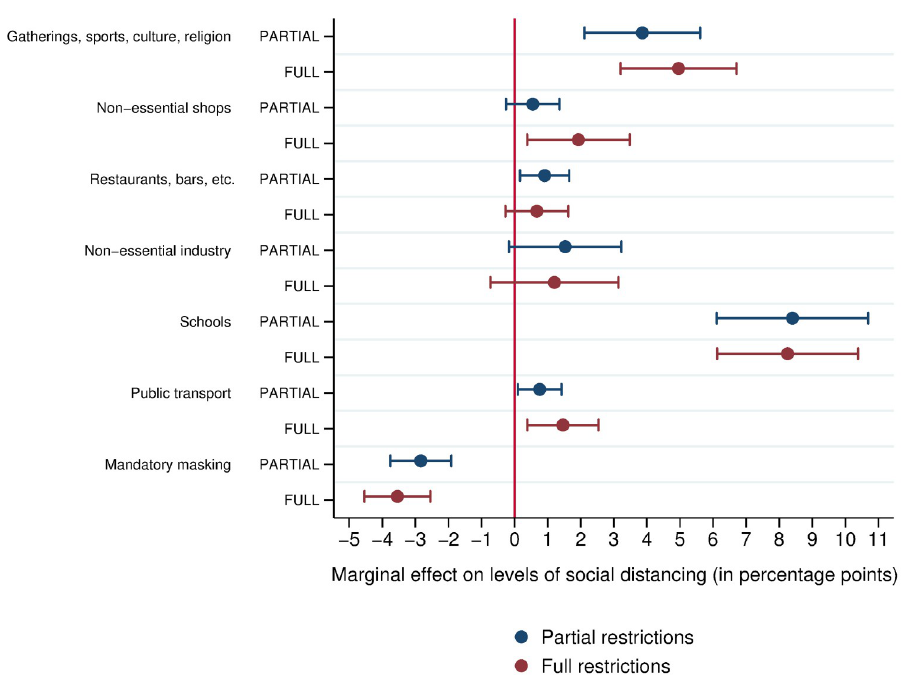
Fig 2. Marginal effect of different types of NPIs on social distancing levels in Brazil (11 th March– 10 th November 2020), considering partial and full restrictions. Marginal effects of different types of mandatory social distancing rules and mandatory masking on levels of social distancing, controlling for the number of days since measures were introduced, whether wearing a mask was mandatory, and including dummies for each Brazilian state (as in model 7, R 2 = 0.72). Error bars indicate 95% confidence intervals. Coefficients of the other variables are in S2 Table.